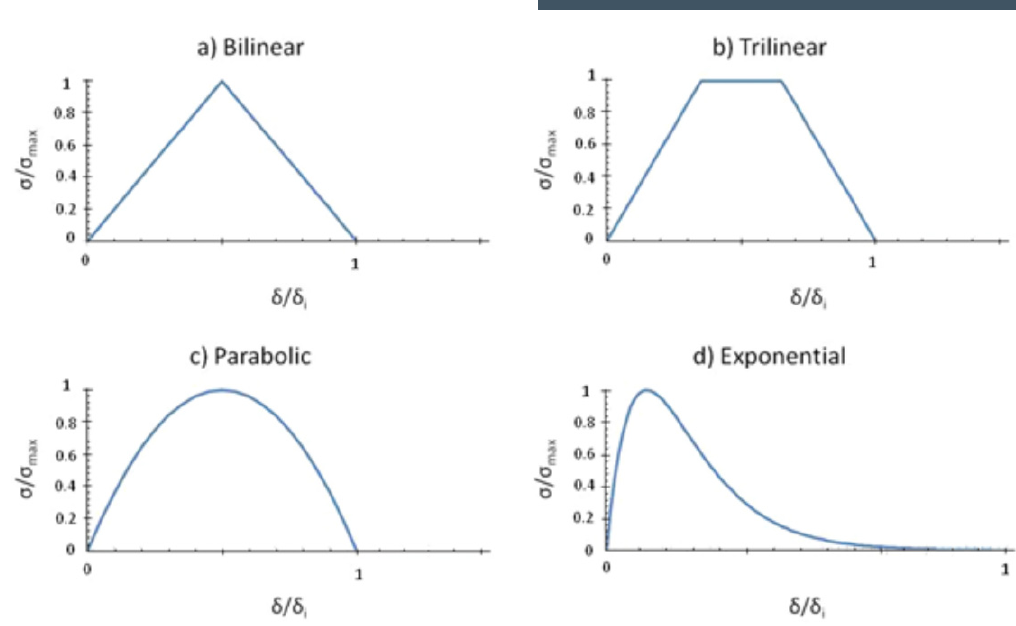
Figure 1. Different forms of the traction-separation